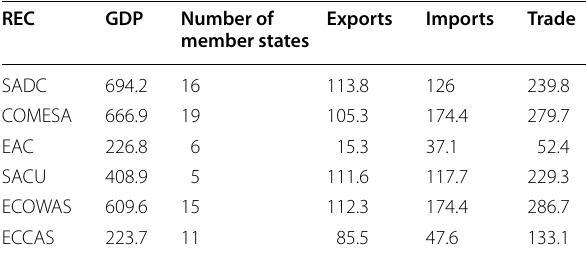
Table 2 Trade potential of African economic communities